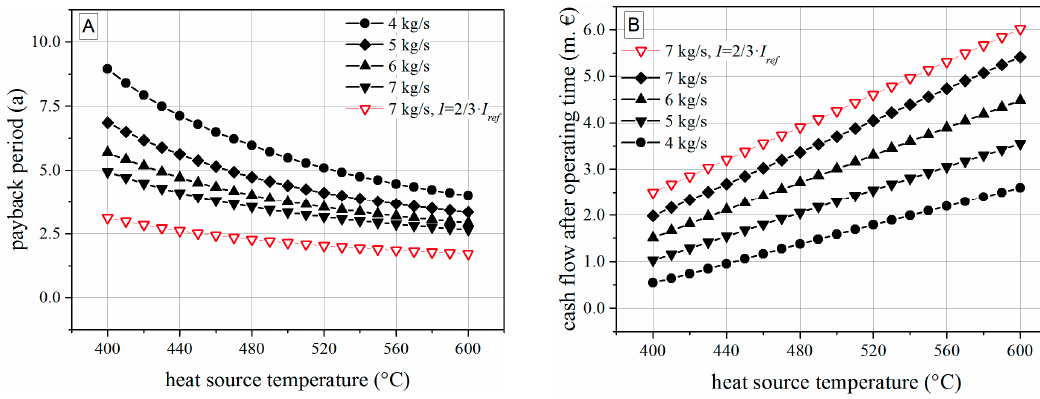
Figure 14. Payback period ( A ) in years and cash flow ( B ) in million € after operating time for hexamethyldisiloxane at different mass flow rates (red and hollow triangles: assumption of reduced investment costs).